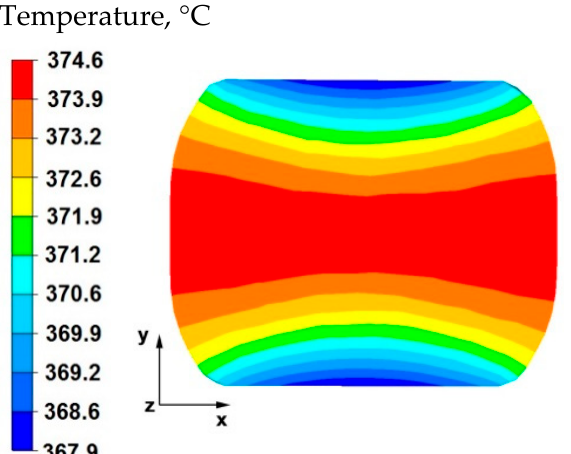
Figure 2. Distribution of temperature values on the surface of the cross-section of the sample with modeled discontinuity after rotation by 90° and re-deformation with 35% reduc- tion.